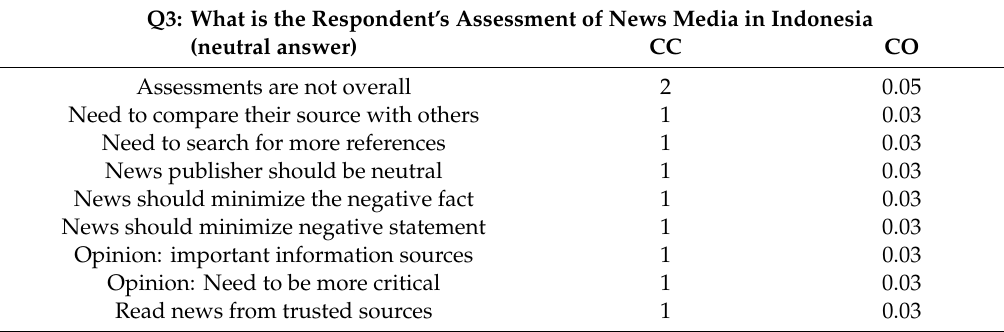
Table 17. Co-occurrences of Question 3, neutral.